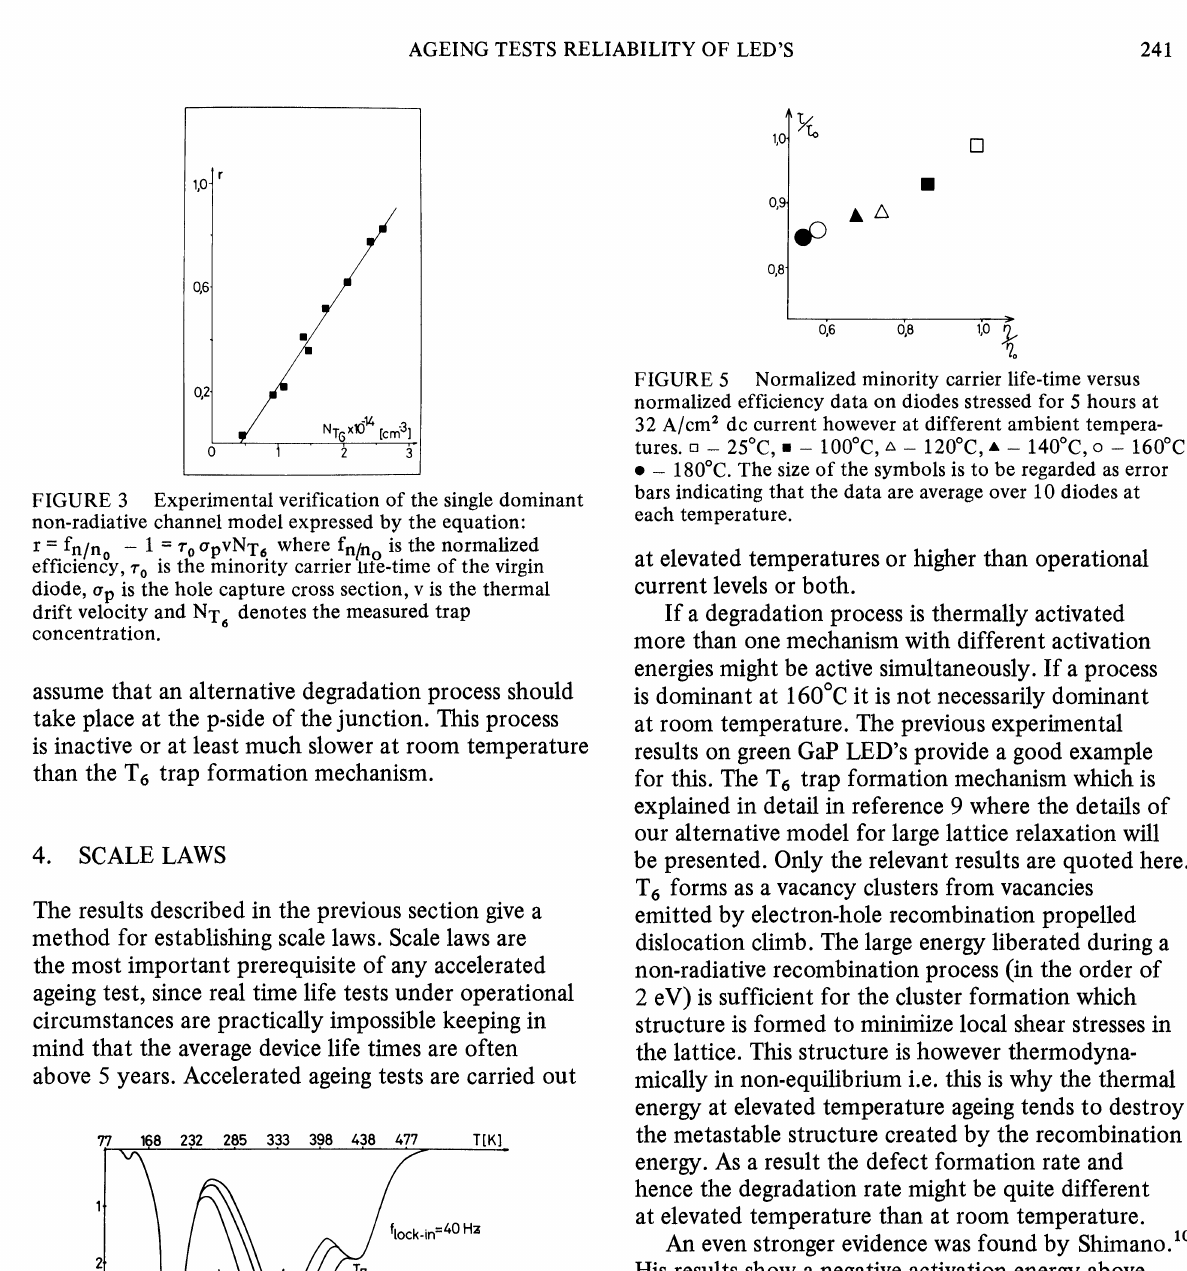
The influence of the ambient temperature during current stressing on the DLTS spectra. The samples where stressed at 32 A/cm dc. for 5 hours. The light output reduced to 83% at 100C, 79% of 120C and 54% at 160C. The dashed curve schematically illustrates the T peak position at room temperature ageing experiments.